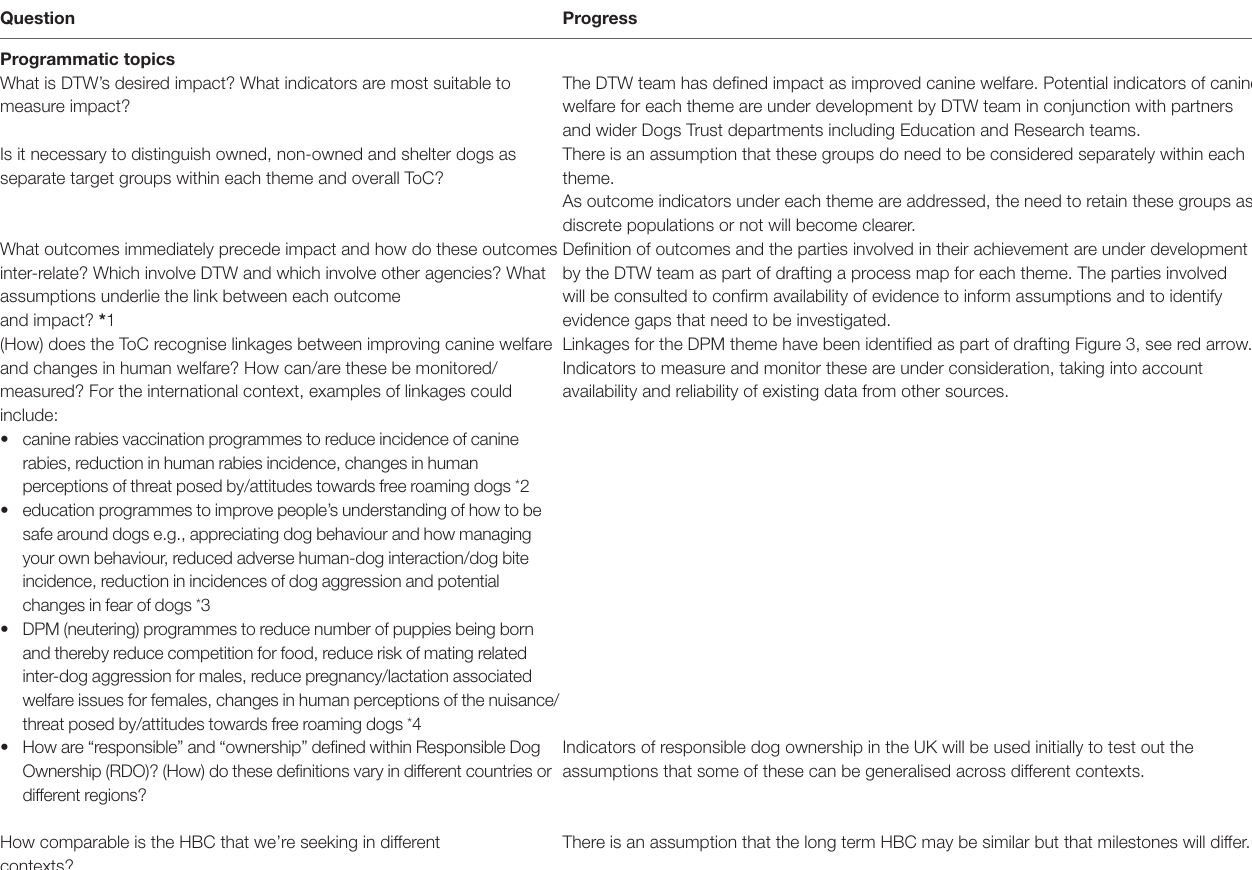
taBLe 1 | Questions arising during the development of Dogs Trust Worldwide’s Theory of Change Items that are illustrated for Dog Population Management theme in Figure 3 are annotated by a star and a number to indicate the relevant step. Question